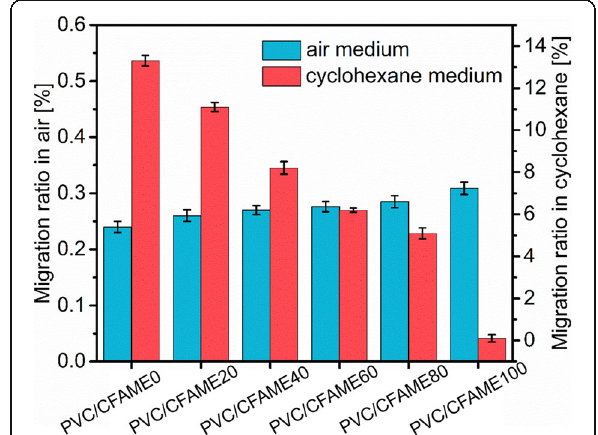
Fig. 5 Migration ratio of PVC/CFAME x coatings in air at 70 °C for 48 h and in cyclohexane medium at 30 °C for 48